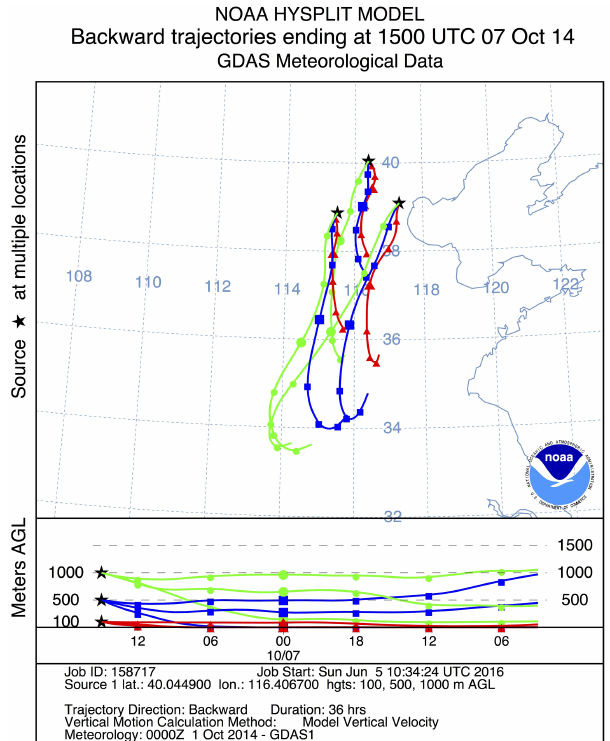
Figure 6. Backward trajectories of NNCP (Beijing, Tianjin and Baoding) during S1 (12:00–00:00LT on 6–8 Oct) in different heights of 100, 500 and 1000m.